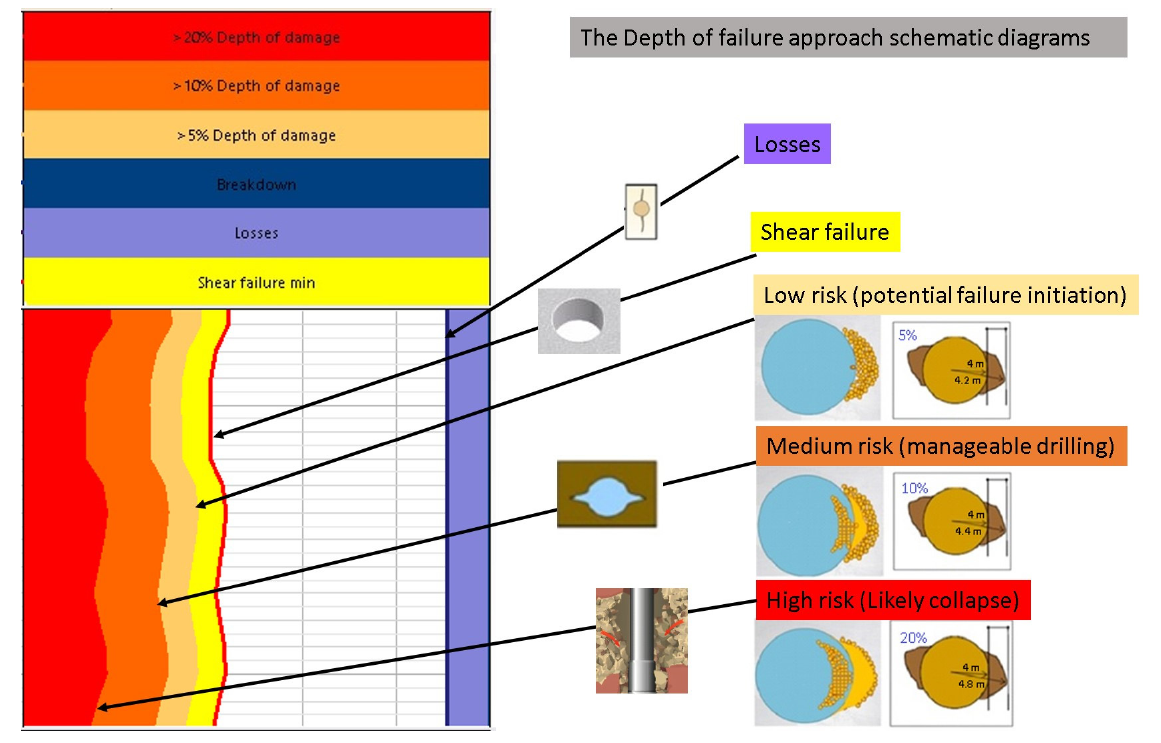
Figure 4. The DOD approach schematic diagrams show the consequences of 5%,10%, and 20% wellbore damage.